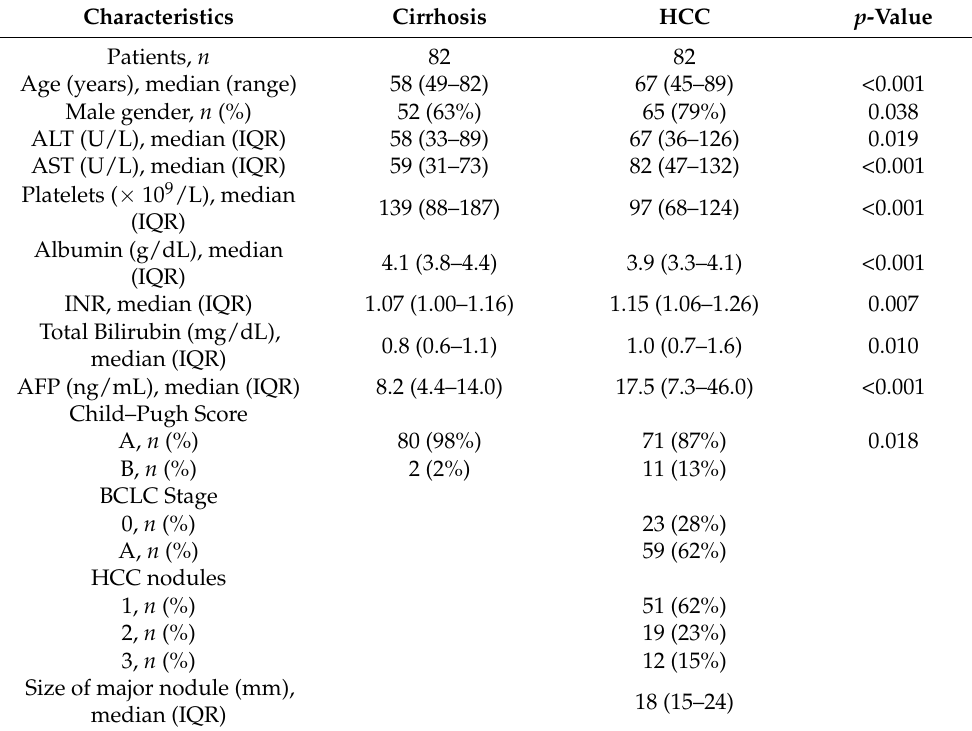
Table 1. Characteristics of the patients included in the study according to hepatocellular carcinoma (HCC)